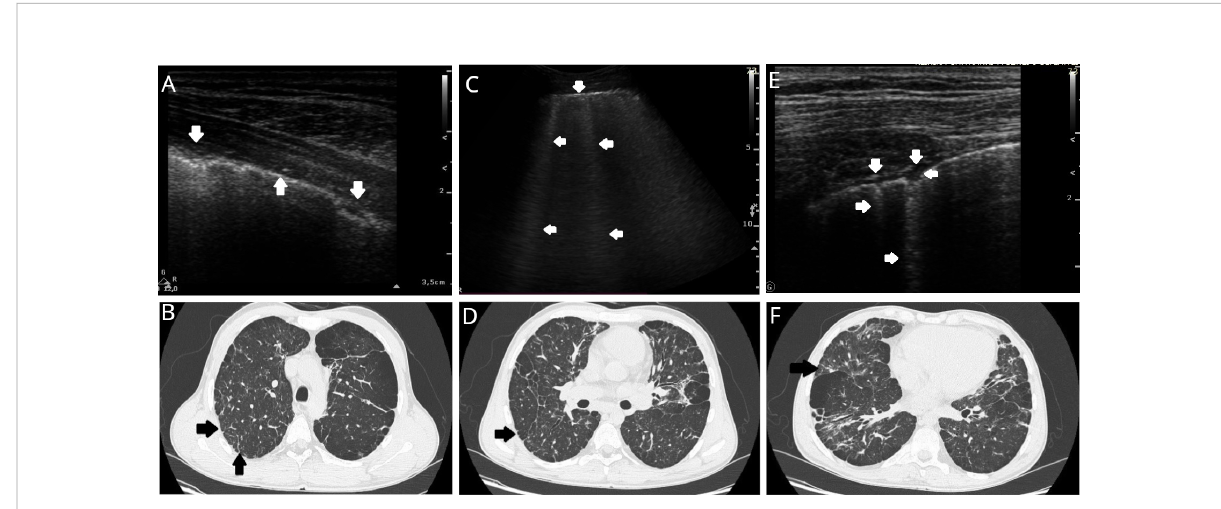
FIGURE 2 Examples of lung lesions in a patient with predominantly antibody de fi ciency on lung ultrasound (LUS) and high-resolution tomography (HRCT). (A) LUS: Irregular and in fi ltrated pleural line ( ↓ ), regular pleural line ( ↑ ). Linear probe. (B) HRCT (axial plane): Right lung - peripheral paraseptal emphysema with centrilobular emphysema inside the lung and fi brosis, thickening of the pleura between the arrows with subpleural fi brosis (arrowheads). Left lung combined centrilobular and panlobular emphysema with fi brosis. (C) LUS: Irregular pleural line ( ↓ ) and multiple B lines ( ← ). Convex probe (1-6MHz). (D) HRCT (axial plane): Right lung - peripheral paraseptal emphysema with centrilobular emphysema inside the lung and fi brosis (arrowhead). Left lung combined paraseptal and centrilobular emphysema with fi brosis. (E) LUS: Irregular pleural line, and small subpleural consolidation ( ↓← ) with vertical artifact C line (arising from subpleural lesion) ( ! ). Linear probe. (F) HRCT (axial plane): Right lung – combined paraseptal, centrilobular and panlobular emphysema and fi brosis, thickening of the pleura with subpleural fi brosis (arrowhead). Left lung combined paraseptal, centrilobular and panlobular emphysema with fi